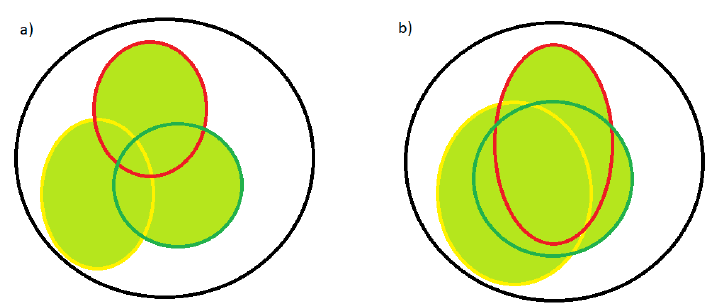
Figure 6. Performance of the combined model before ( a ) and after ( b ) hyperparameter search. The black set represents the entire dataset and each of the three smaller sets (red, yellow and green) is a sub-set of the samples that were classified correctly by using each feature type. The green area is the sub-set of the samples classified correctly by the combined model.